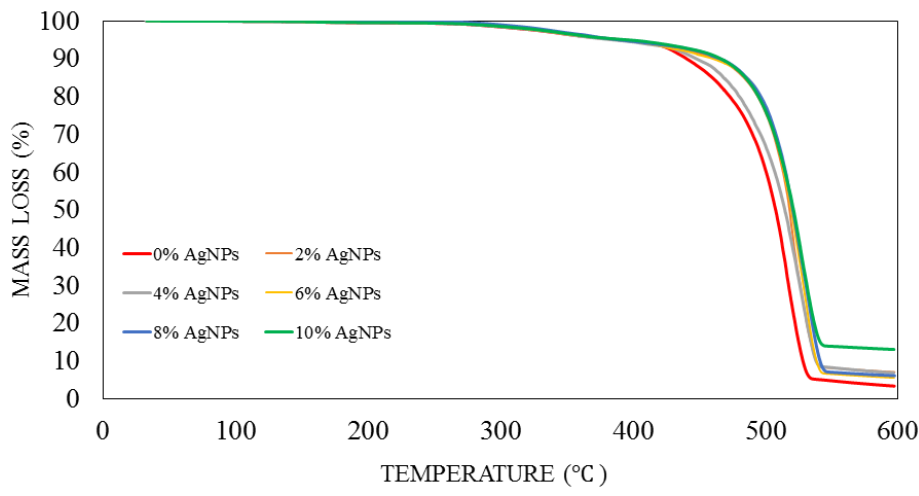
Figure 8. TGA of kenaf/HDPE composites at different AgNP contents.